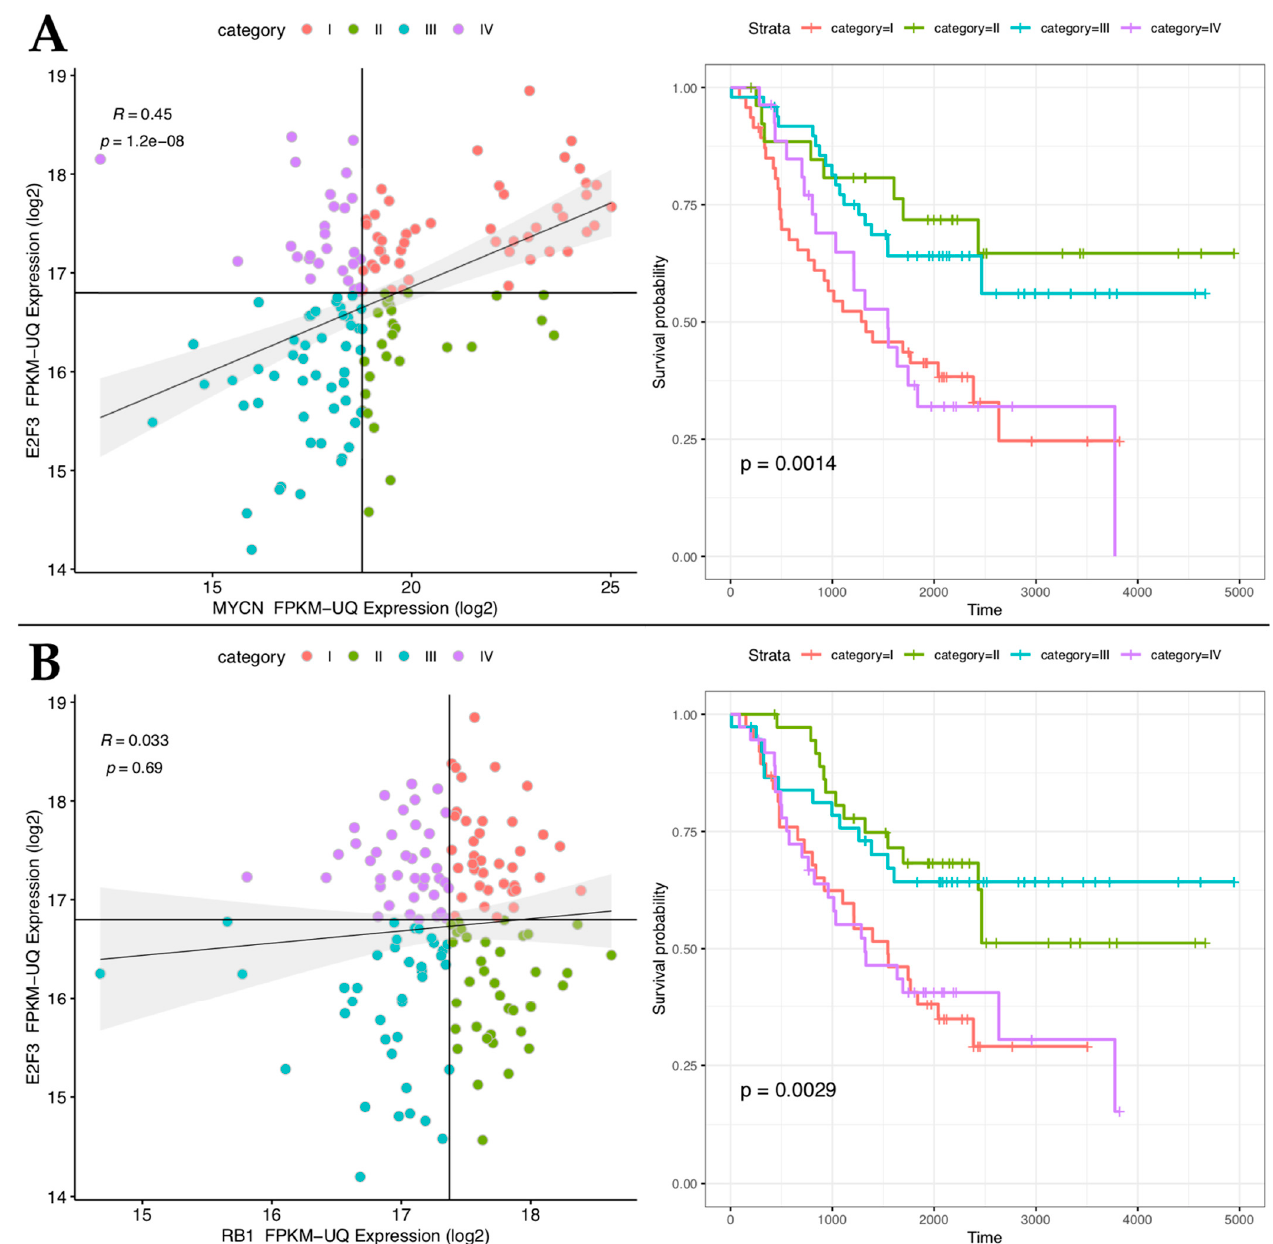
Figure 1. High expression of E2F3 correlates with poor prognosis despite the MYCN and RB1 levels. Left-( A ): Spearman’s correlation between E2F3 (y-axis) and MYCN (x-axis) in a cohort of 152 target NBL patients. Left ( B ): Spearman’s correlation between E2F3 (y-axis) and RB1 (x-axis) in a cohort of 152 target NBL patients. Correlation coefficient (R) and p -value of correlation test are indicated. Right ( A,B ): Overall survival analysis of the target NB dataset for each previously defined category. Correlation coefficient (R) and p -value of correlation test are indicated. Samples are divided into four categories as described in Methods (colored as in legend). Colors of Kaplan Meier curves as in legend. The p -value of the log-rank test is indicated. p -value of proportional hazard assumption was 0.27 and 0.13 for ( A ) and ( B ), respectively.